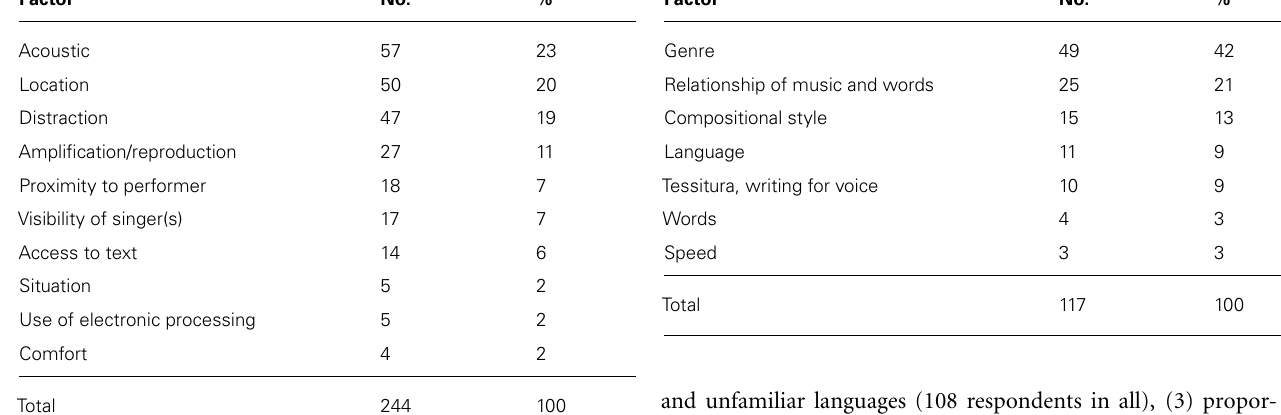
Table 5 |The number of statements (No.) and percentage (%) of music- and words-related factors affecting sung text intelligibility. No.